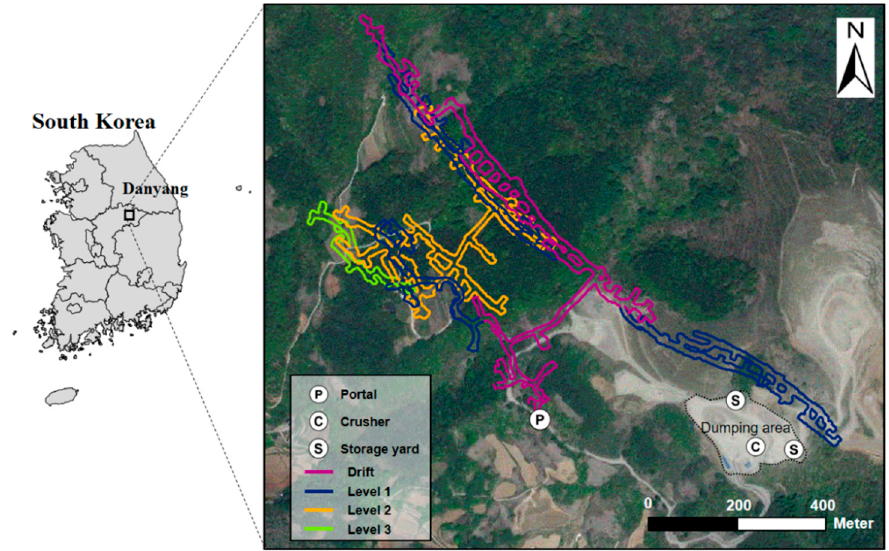
Figure 1. Aerial view of the study area showing drifts inside the mine and outside facilities. (Image source: National Geographic Information Institute of South Korea).